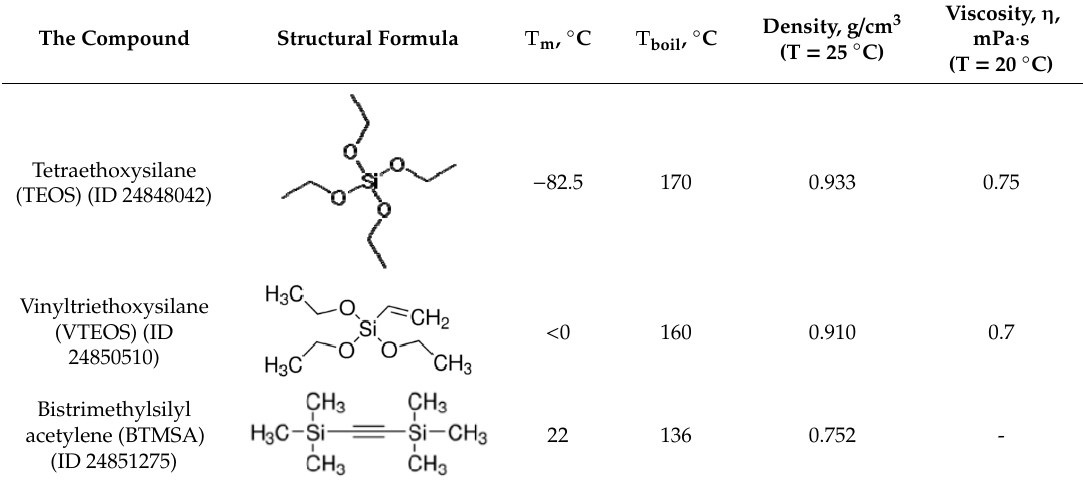
Table 1. The main characteristics of organosilicon additives.